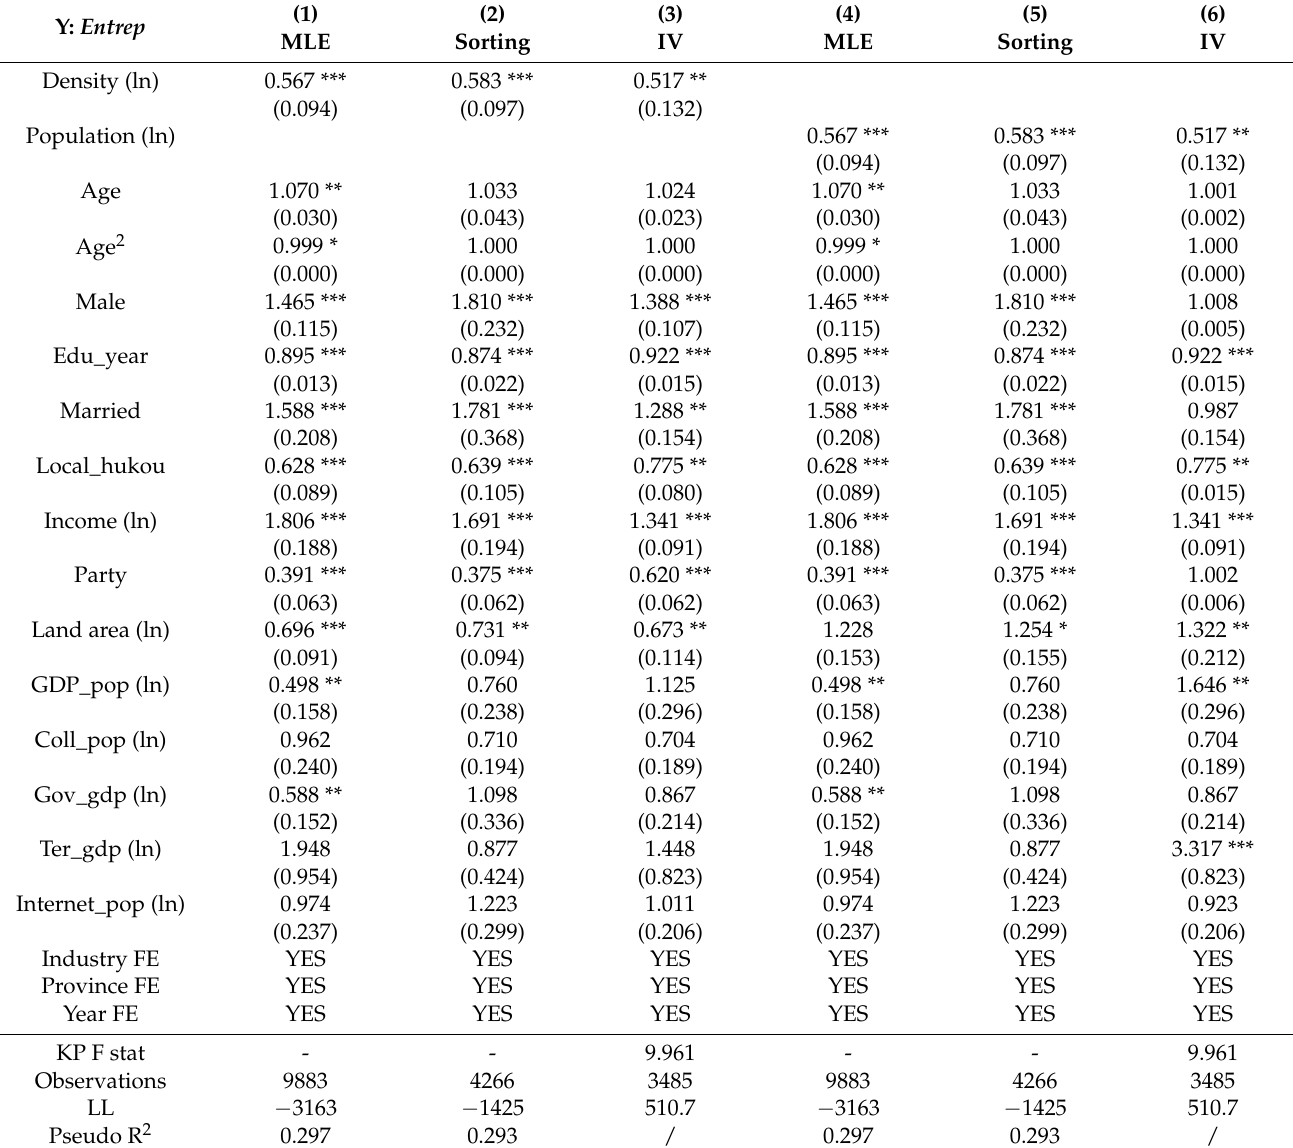
Table 3. Baseline identifications under different